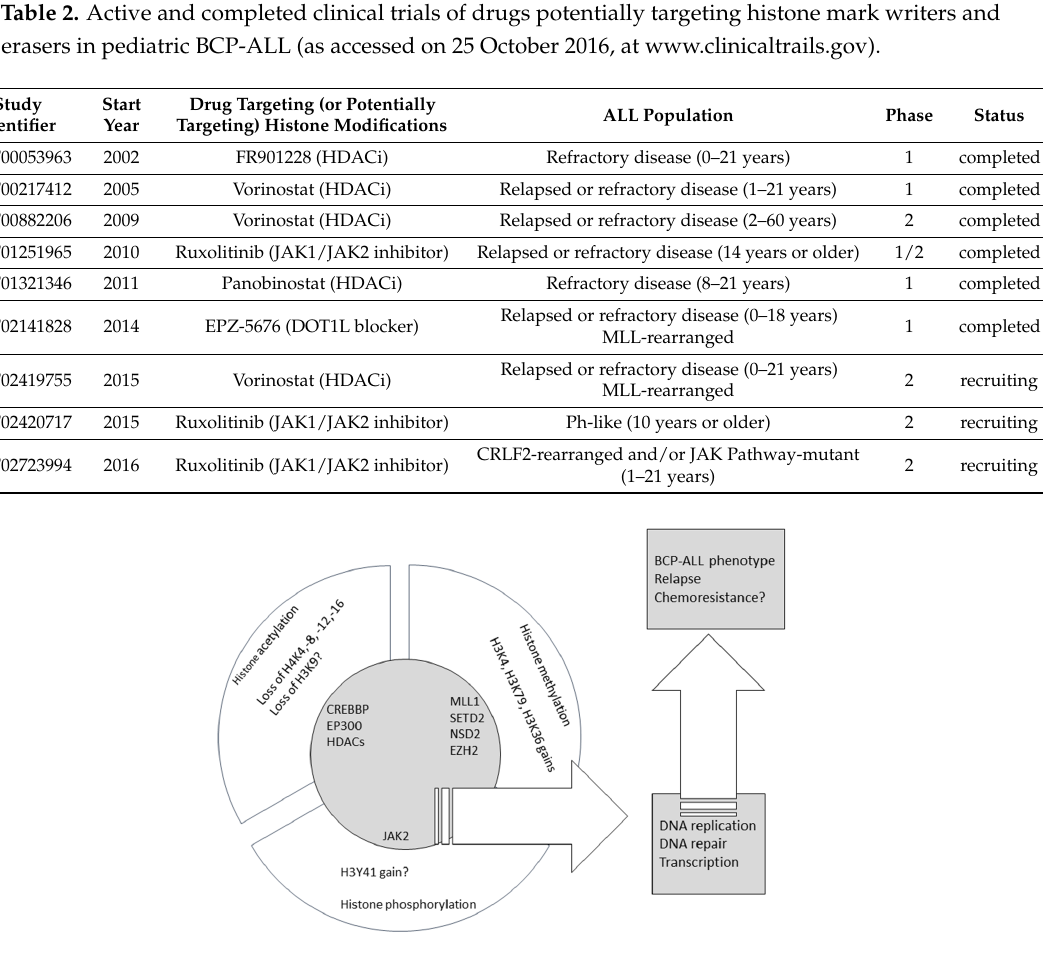
Figure 1. The summary of the published data on aberrant histone marks and mutations in chromatin modifiers in BCP-ALL.